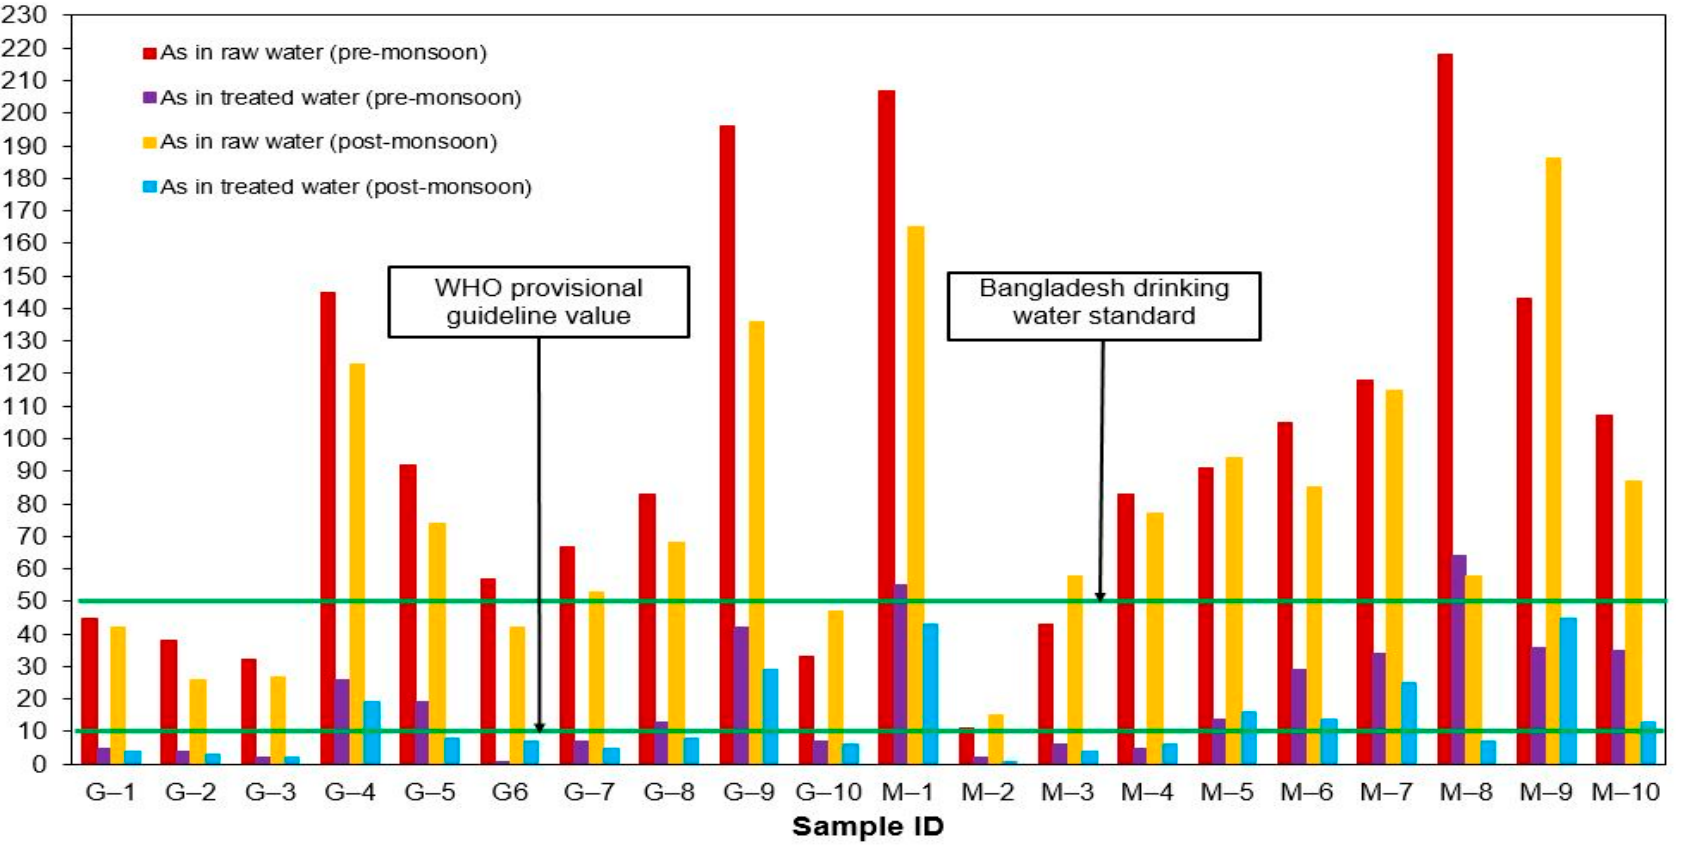
Figure 3. Concentration of As (µg/L) in raw and treated water during pre-monsoon and post-monsoon from rural areas in Bangladesh. The green lines indicate the provisional guideline value of WHO and standard limit of Bangladesh.